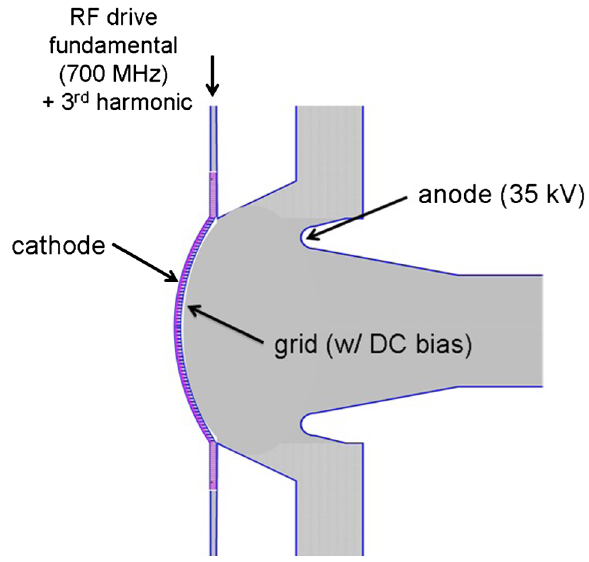
FIG. 19. Geometry of a thermionic IOT gun with a closed cathode (compare Fig. 14), used for the PARMELA simulations of Fig. 20. Field lines of the fundamental (700 MHz) field are shown. In these simulations, the backing plate entirely confines the rf fields to the grid-cathode region. The three-dimensional geometry is symmetric about an axis along the center of the